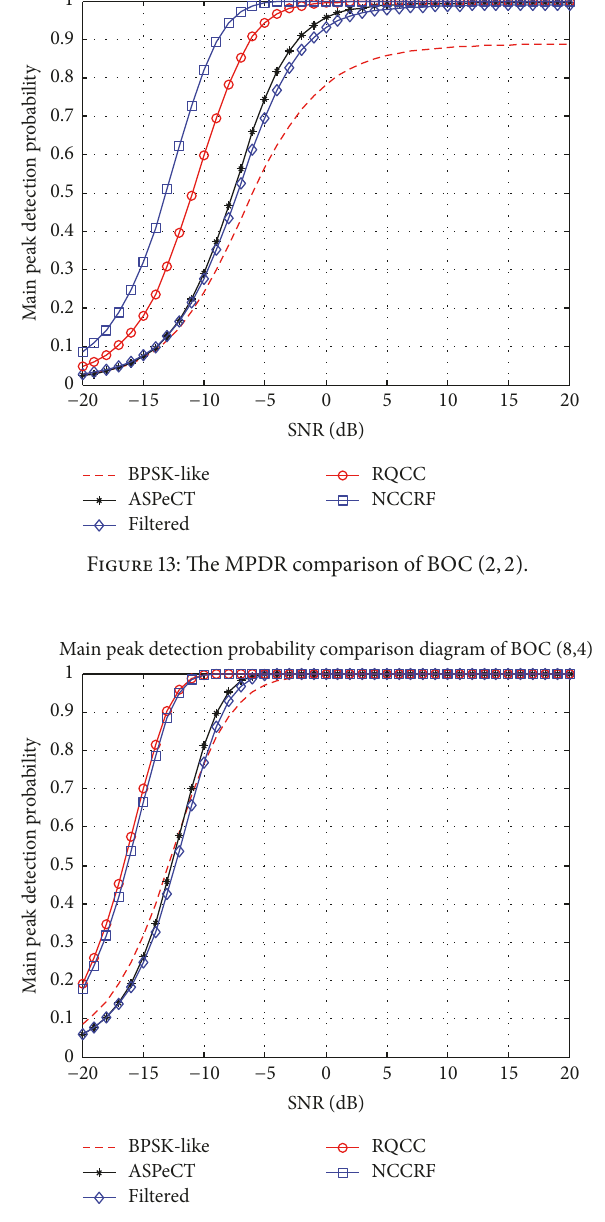
Figure 14: The MPDR comparison of BOC ( 8,4 ).